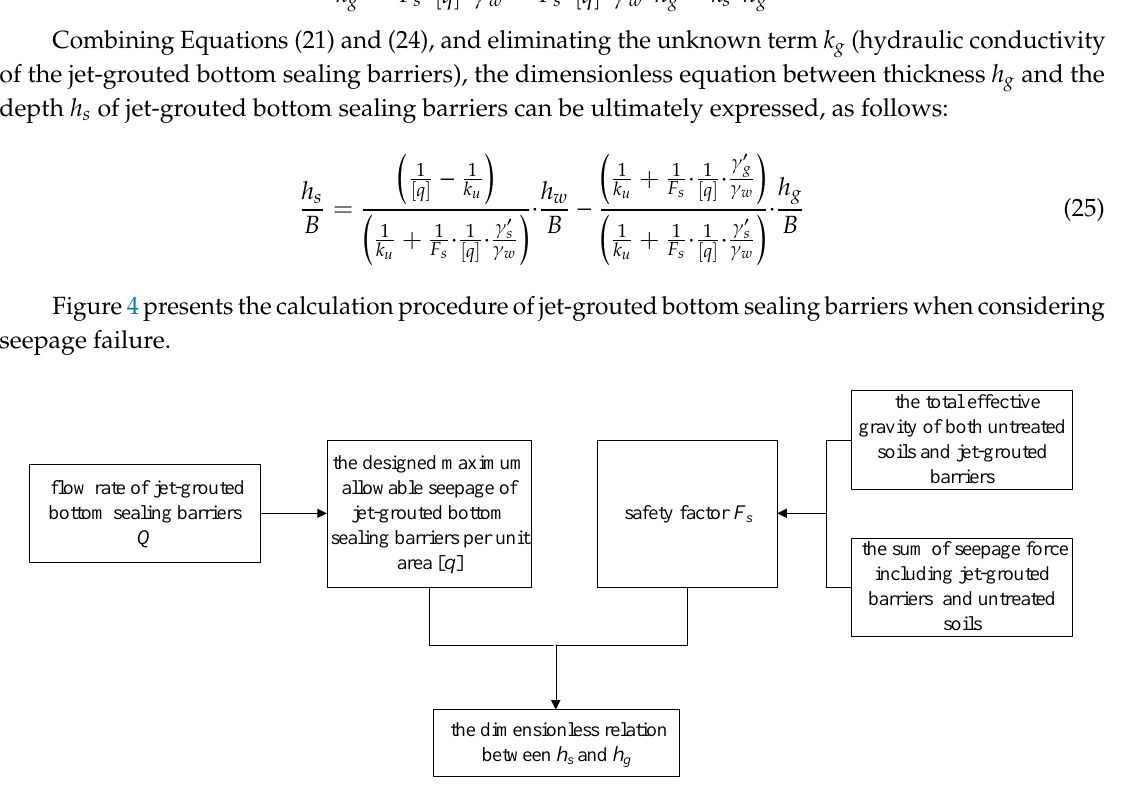
Figure 4. Calculation procedure of jet-grouted bottom sealing barriers considering seepage failure.